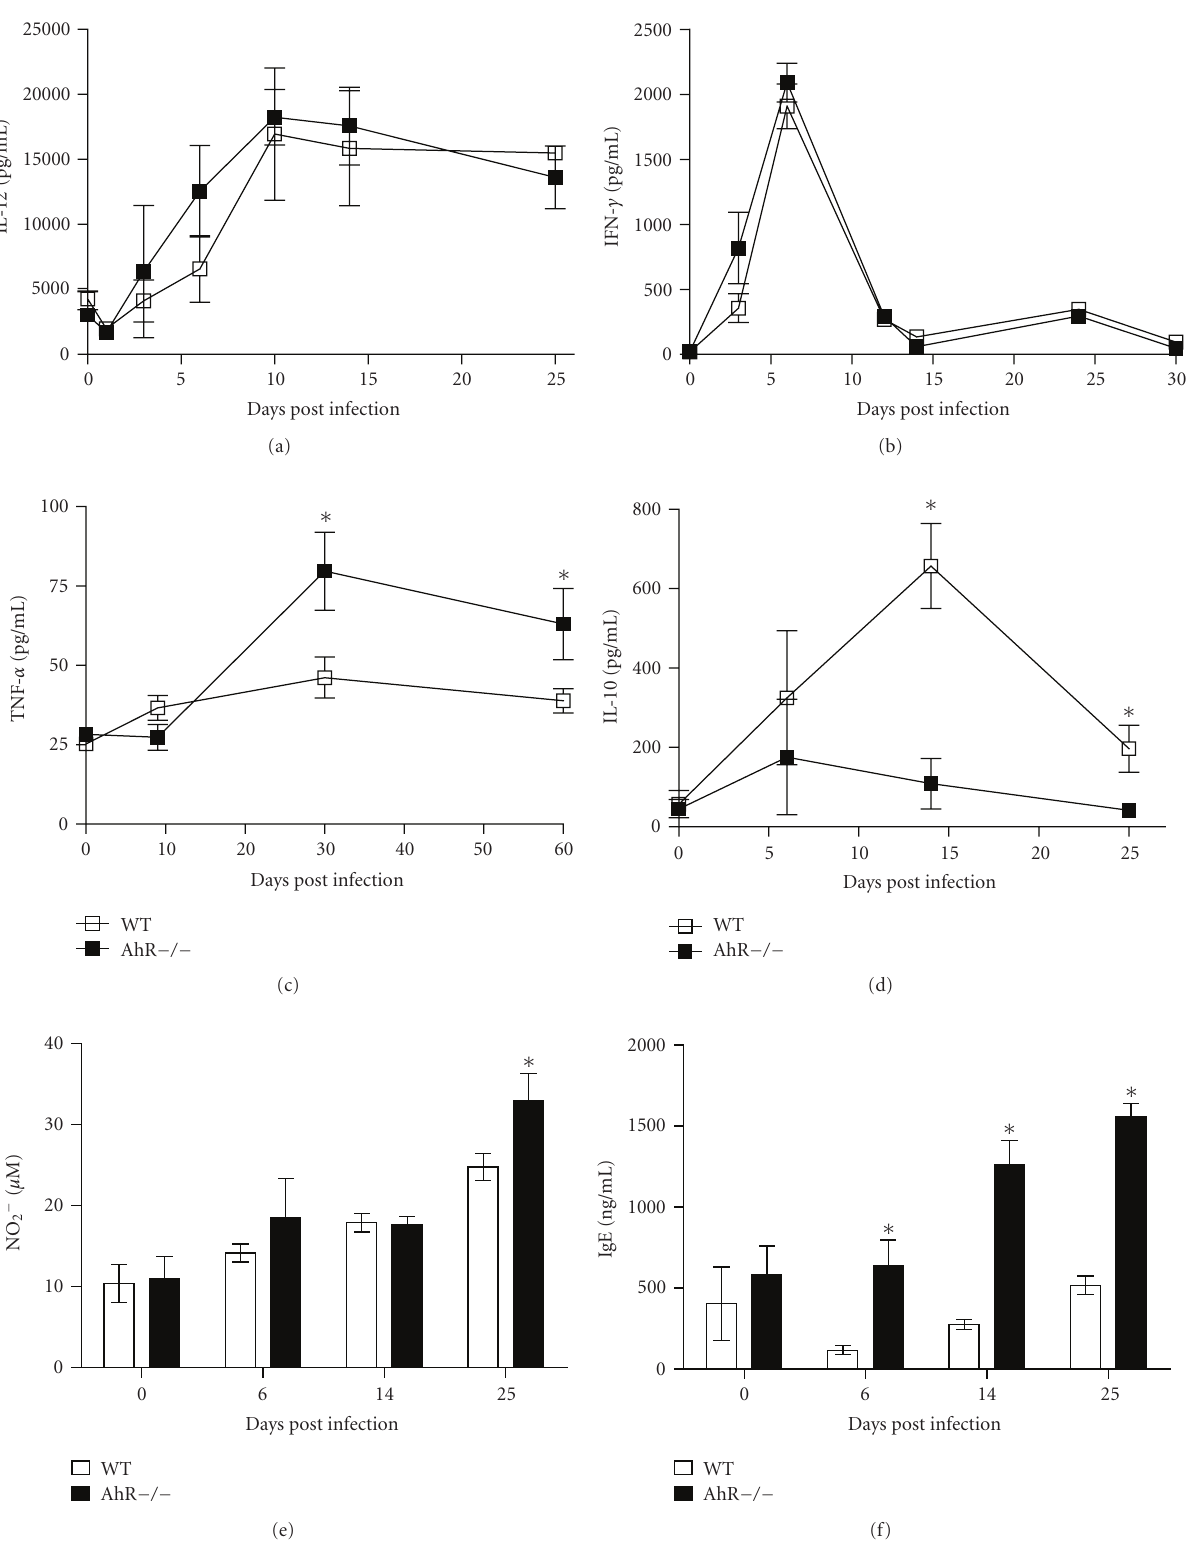
Figure 3: Levels of IL-12p70 (a), IFN- γ (b), TNF- α (c), IL-10 (d) nitric oxide (e), and total IgE (f) in sera from AhR-/- and WT mice infected with 40 cysts of T. gondii . For systemic cytokine, nitric oxide, and IgE production, mice were bled at the indicated time points and the levels of cytokines and total IgE (f) were measured in serum by ELISA and nitric oxide (e) was measured in serum by Griess assay as described above. The values presented are the mean + SD of triplicate samples of 6 animals per time point per group. ∗ P < . 05 with respect to WT, Student’s t